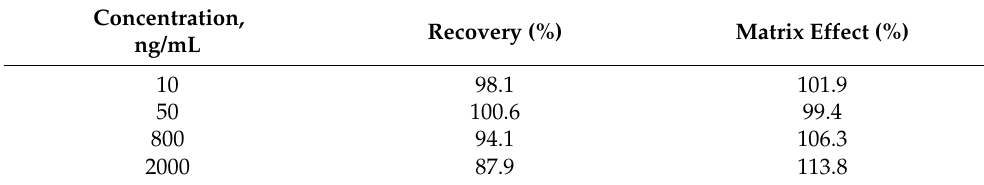
Table 2. Recovery and matrix effect.